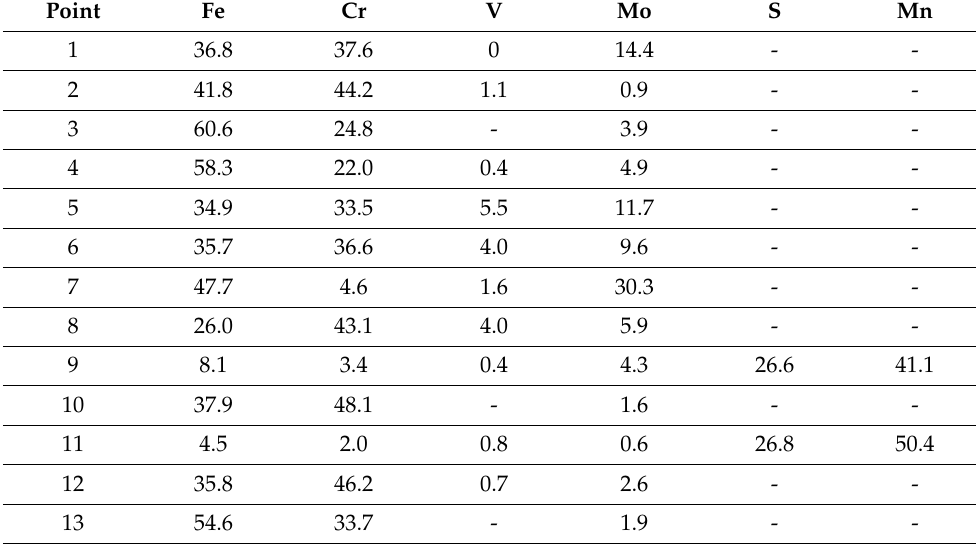
Table 2. The atomic percentage of tool steels used in the study in SEM images by EDS. Point